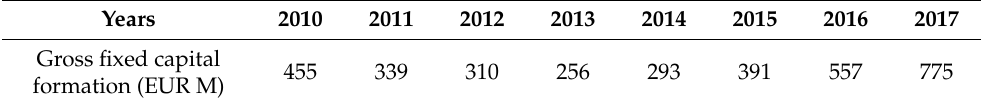
Table 2. Gross fixed capital formation in the Portuguese automotive industry from 2010 to